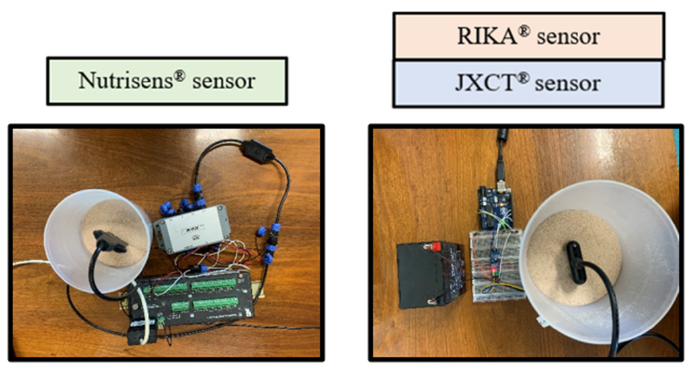
Figure 6. Process of reading of the probes in sand.